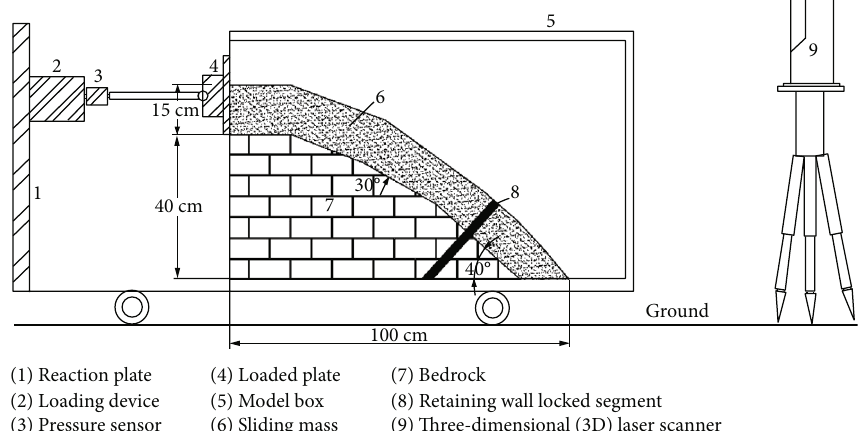
Figure 2: The experimental equipment.